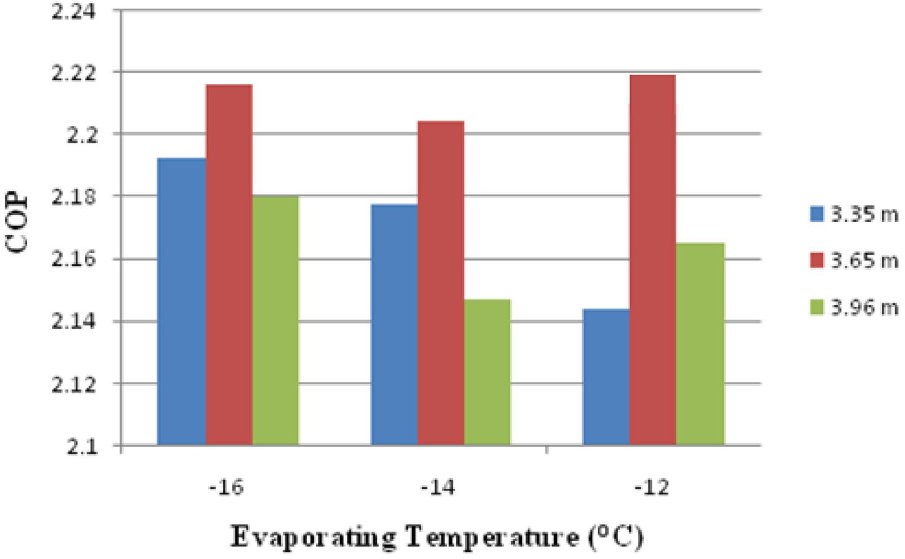
Figure 10. Variation of COP against capillary length and evaporating temperature.